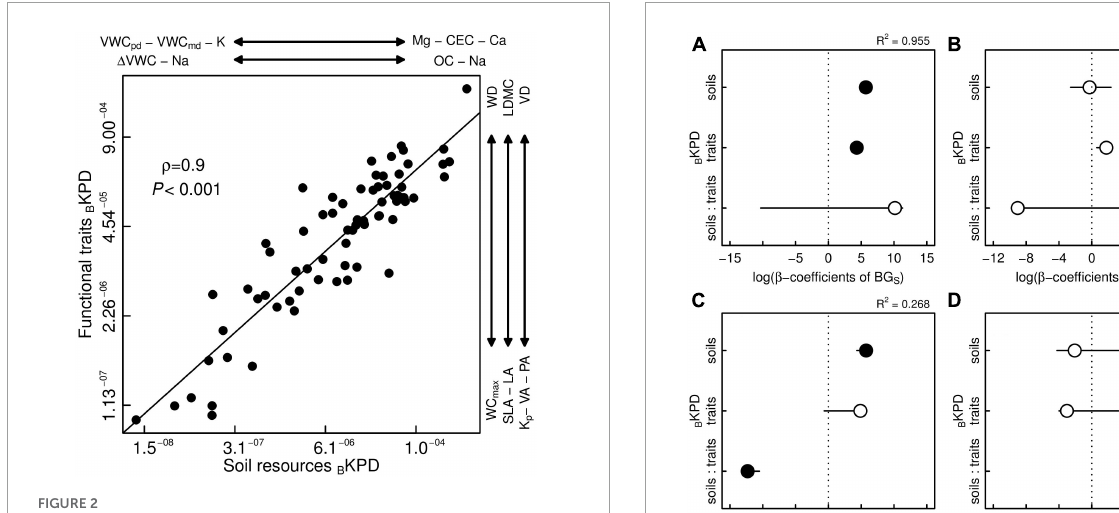
FIGURE2 Pearson’s pairwise correlation of bivariate kernel probability densities of the TDF species biomass stocks ( B KPD) between soil resources and functional trait spaces. Soil variables: predawn soil volumetric water content (VWC pd ,%), midday soil volumetric water content (VWC md ,%), daily soil volumetric water content change ( (cid:49) VWC,%), cation exchange capacity (CEC, cmol c kg − 1 ), exchangeable bases [Calcium (Ca), Magnesium (Mg), Potassium (K), Sodium (Na), cmol c kg − 1 ] and organic carbon (OC,%). Functional traits: leaf area (LA, mm 2 ), leaf dry matter content (LDMC, mg g − 1 ), specific leaf area (SLA, mm 2 mg − 1 ), wood density (WD, g cm − 3 ), fiber wall thickness (FWT, µ m), water content at maximum capacity (WC max , kg kg − 1 ), and xylem potential hydraulic conductivity (K p , kg m − 1 s − 1 MPa − 1 ), pit aperture area (PA, µ m 2 ), vessel area (VA, µ m 2 ), vessel density (VD, vessels mm − 2 ).